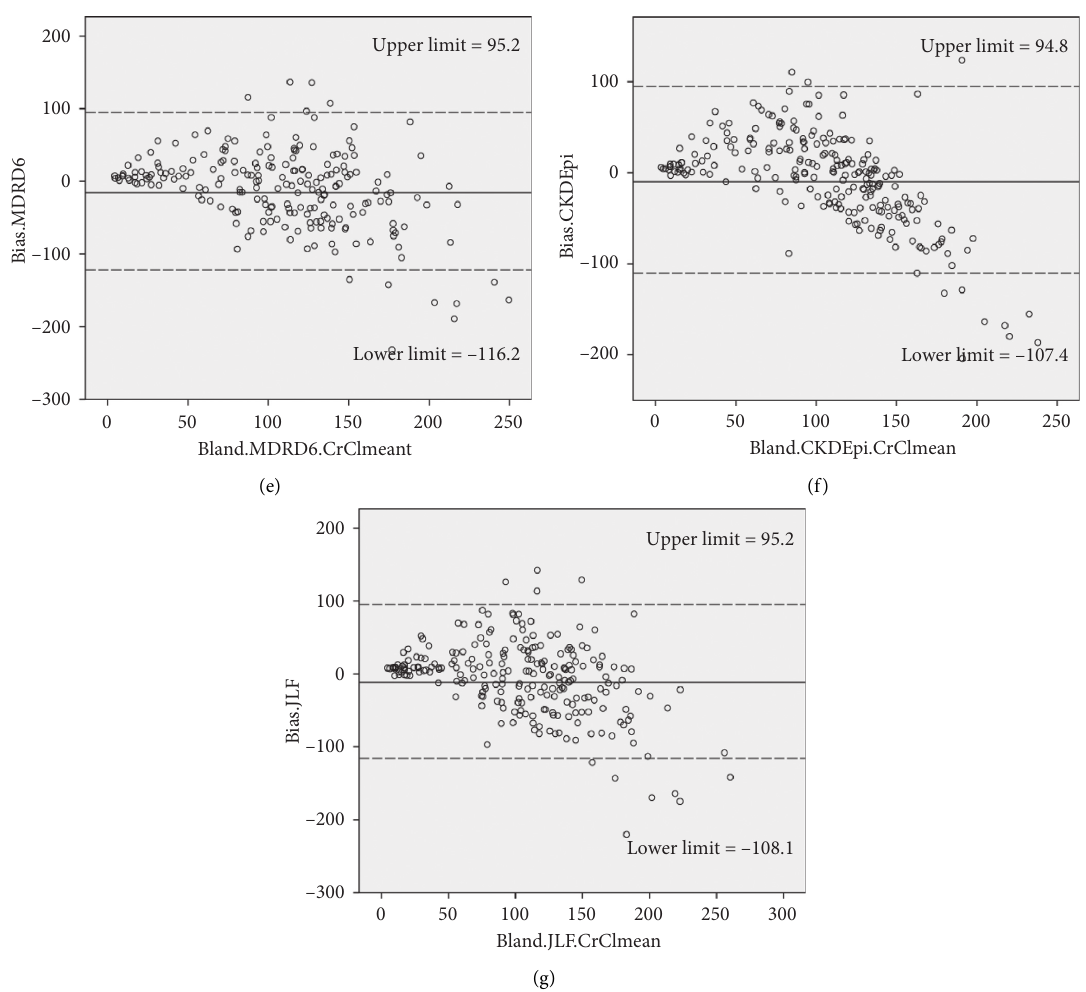
Figure 2: Bland–Altman plot of the creatinine clearance measured by 24-hour urine collection (CrCl 24h-urine ) versus the equations es- timating glomerular filtration rate. (a) Cockroft–Gault equation using actual body weight; (b) Cockroft–Gault equation using ideal body weight; (c) Cockroft–Gault equation using adjusted body weight; (d) 4-variable modification of diet in renal disease equation; (e) 6-variable modification of diet in renal disease equation; (f) chronic kidney disease epidemiology collaboration equation; and (g) Jelliffe equation. The X -axis represents the difference between CrCl 24h-urine and the equation estimating glomerular filtration rate. The Y -axis represents the mean of CrCl 24h-urine and the equation estimating glomerular filtration rate. The solid line represents the bias (mean difference obtained across the range of values), whereas the dashed lines are the limits of agreement ( ± 1.96 × standard